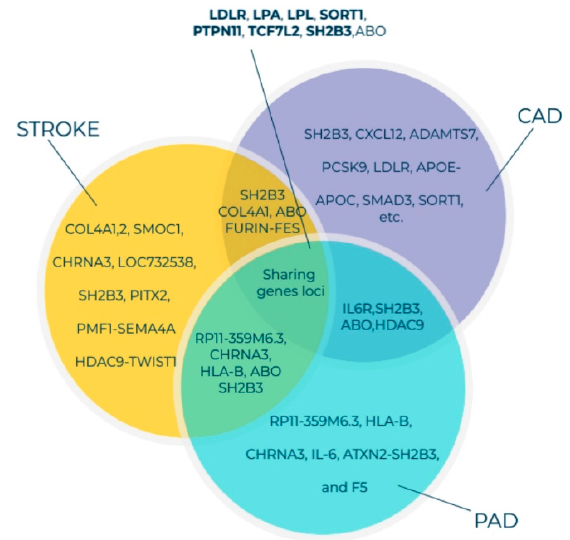
Figure 2. Venn diagram of genes associated with susceptibility to PAD, CAD, and stroke identified through GWAS and the shared gene loci. All listed genes shown here were adapted from the GWAS catalog database for PAD, CAD, and stroke [61–63]. Currently, more than 190, 1060, and 327 gene loci have been identified for PAD, CAD, and stroke, respectively. The GWAS 71 catalog accession date is 18 January 2021 Abbreviations: PAD, peripheral arterial disease; CAD, coronary artery disease; GWAS, genome-wide association studies.